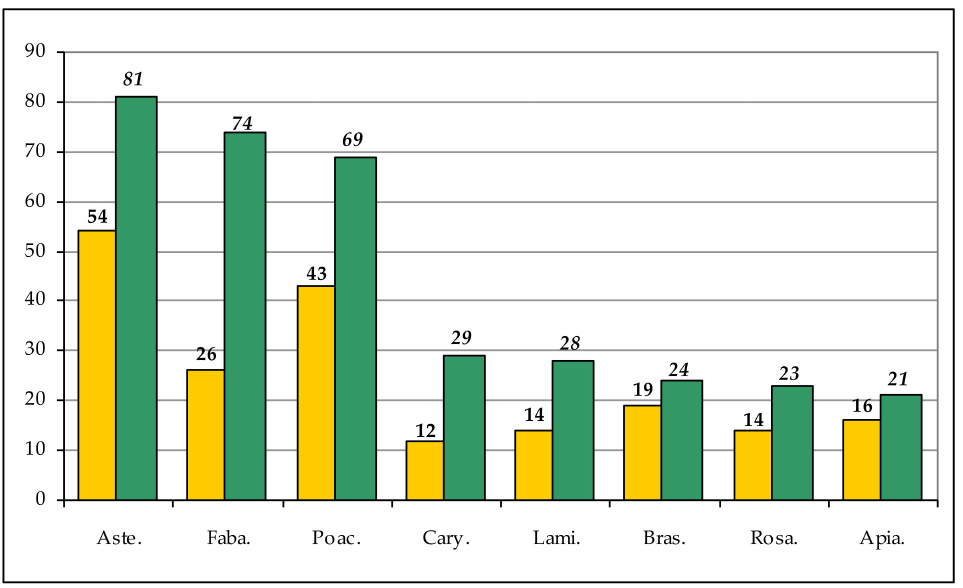
Figure 35. Number of genera (orange columns) and taxa (dark-green columns) per family; only the richest families (more than 20 taxa (species and subspecies)) are displayed. Abbrevi- ations: Aste. = Asteraceae; Faba. = Fabaceae; Poac. = Poaceaeae; Cary. = Caryophyllaceae; Lami. = Lamiaceae; Bras. = Brassicaceae; Rosa. = Rosaceae; Apia. = Apiaceae.